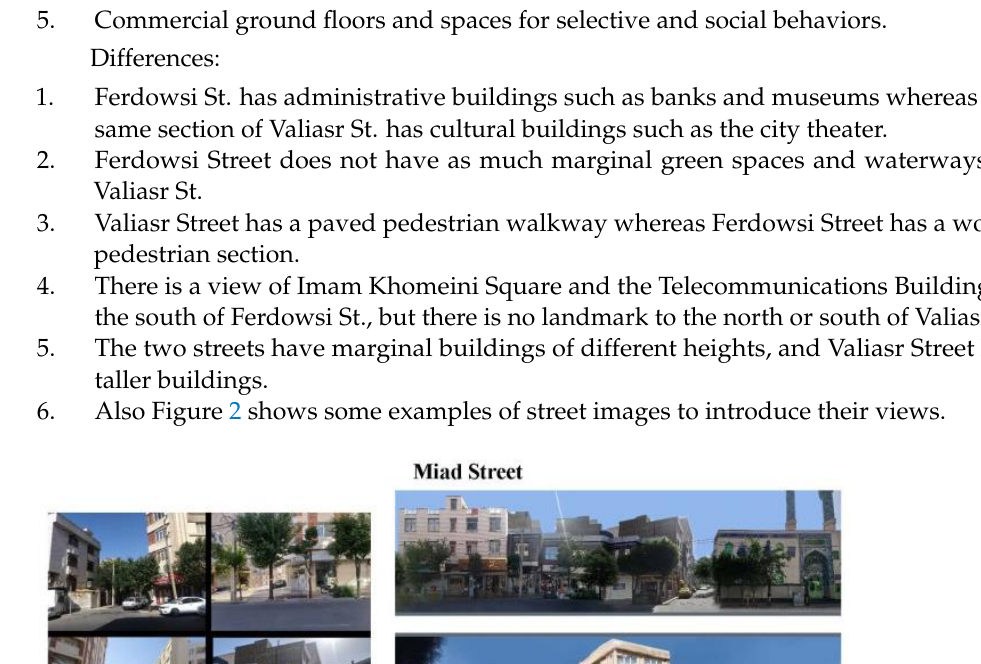
Figure 2. Sample photos of selected streets.